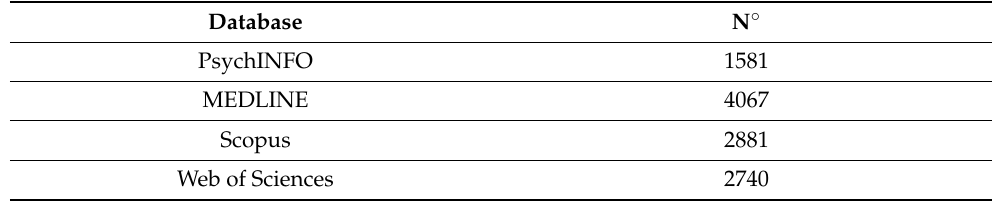
Table 1. Number of selected articles in